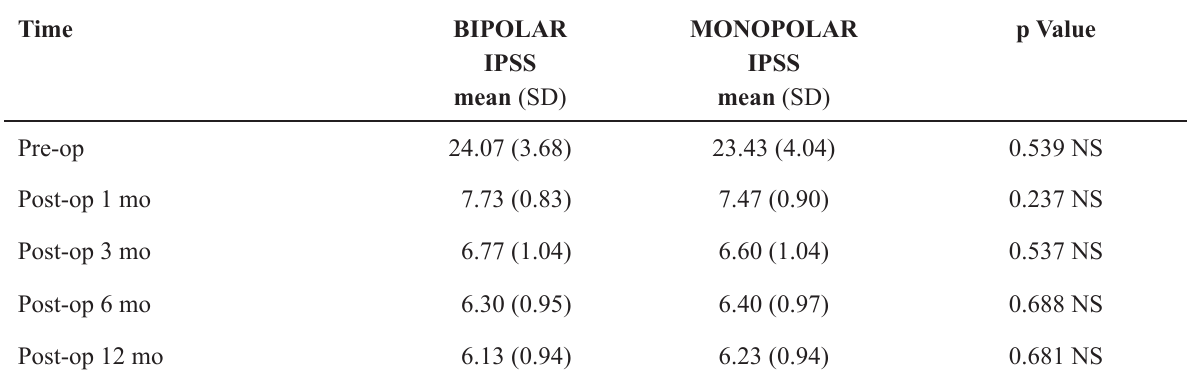
Table 4 – Comparison of IPSS between bipolar and monopolar